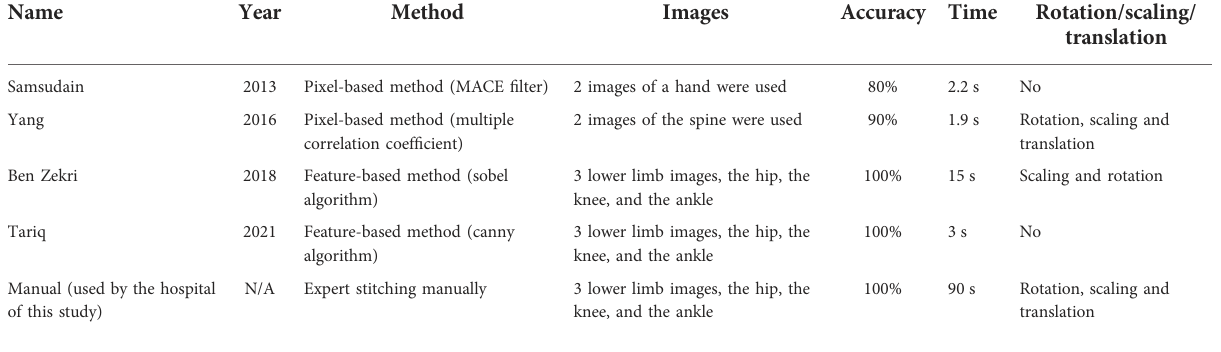
TABLE 3 A comparison between different stitching methods and their ef fi